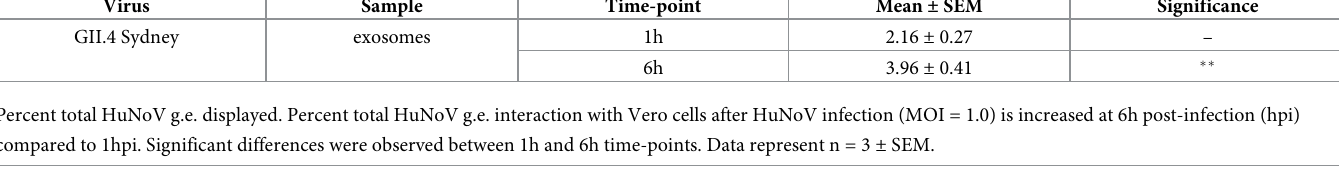
Table 1. GII.4 Sydney HuNoV levels by qRT-PCR.